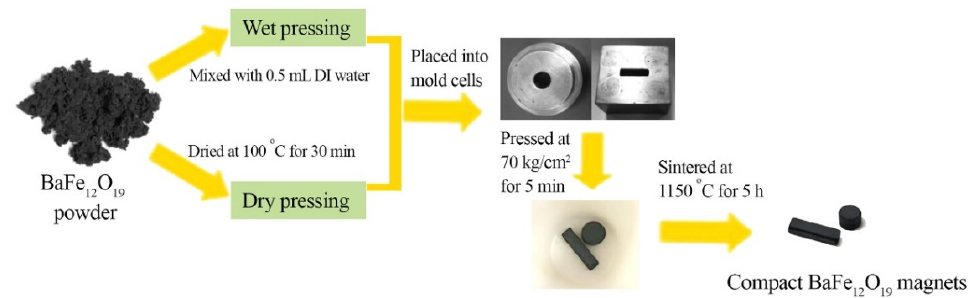
Figure 1. Production steps for BaFe 12 O 19 magnets by powder